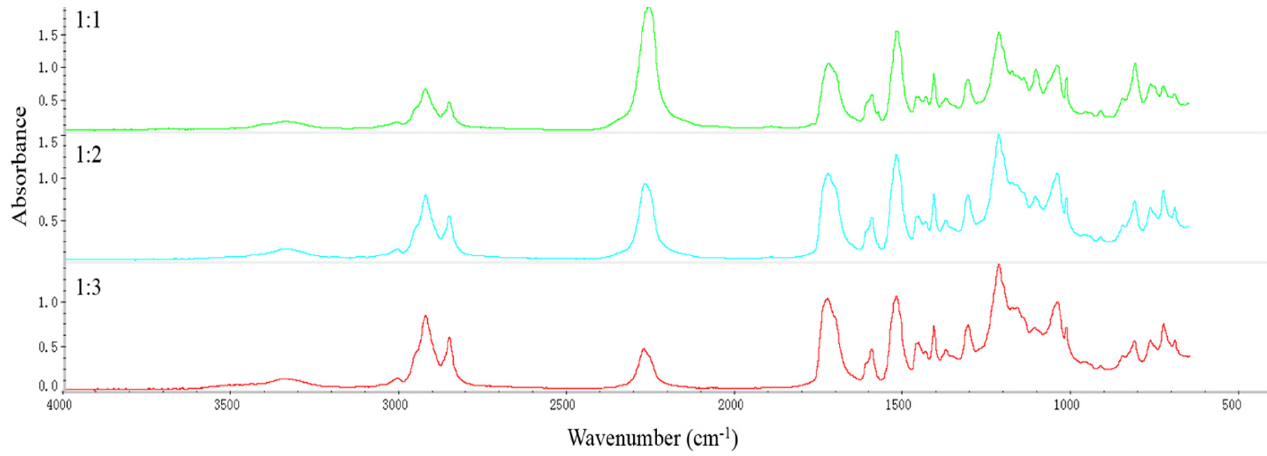
Figure 5. Infrared analysis results after reaction of isocyanate component and polyol liquid.